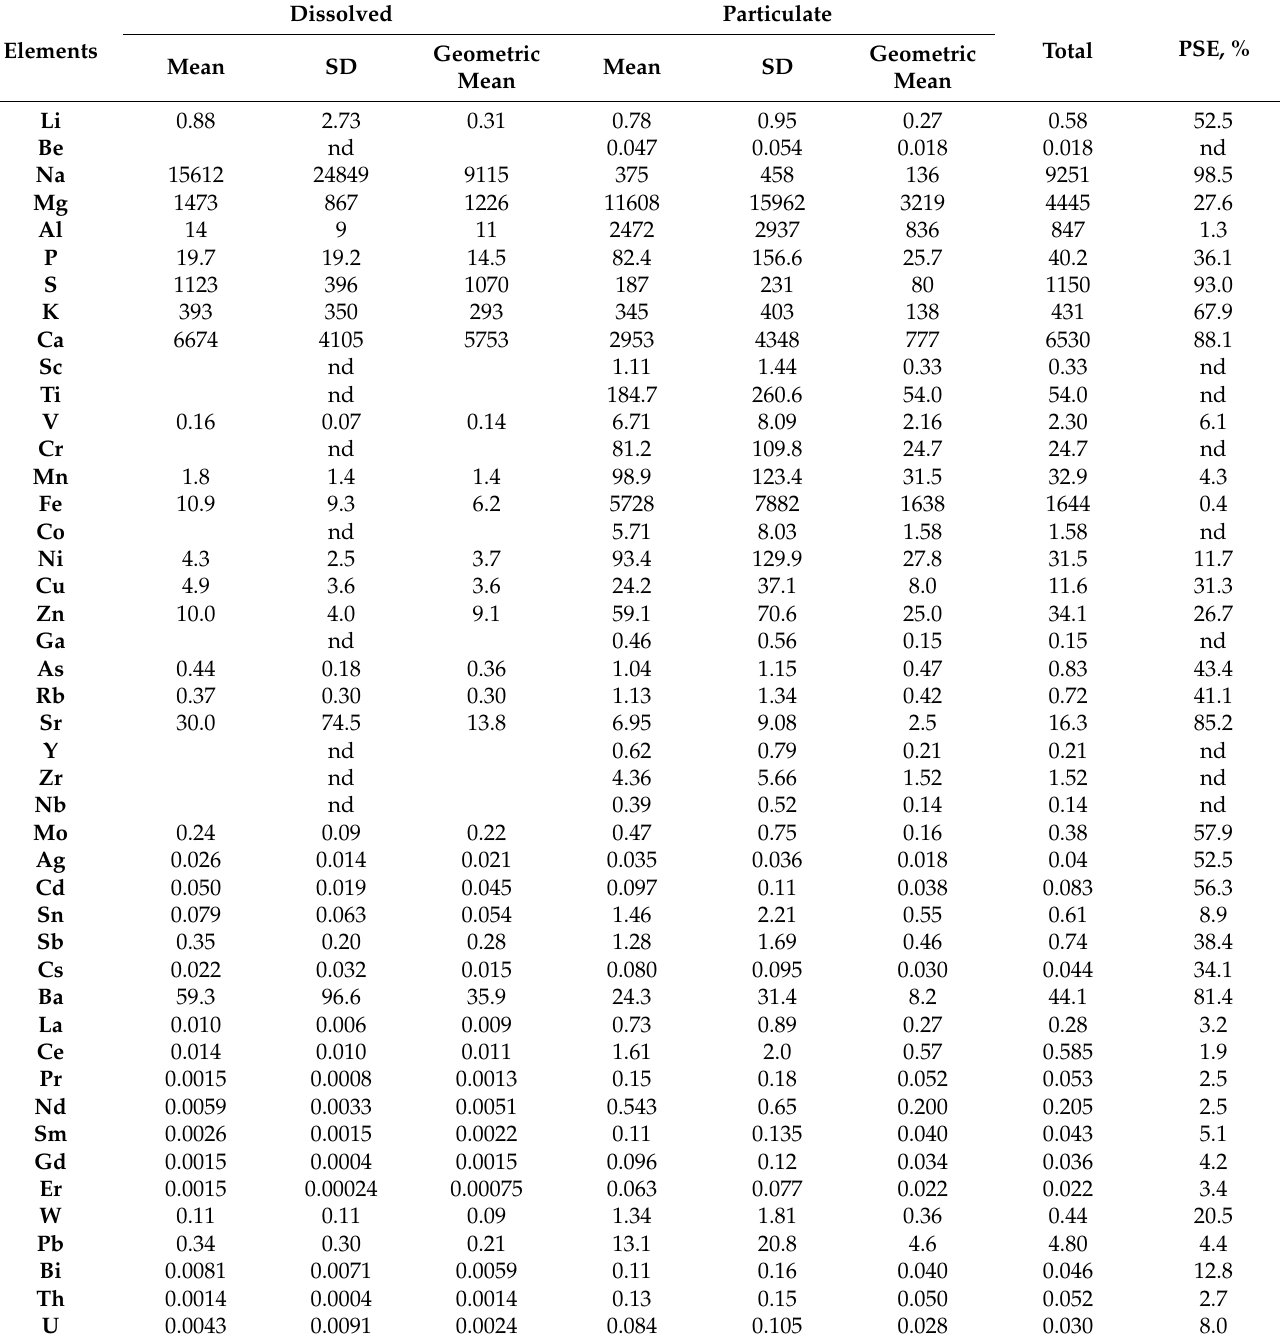
Table 2. The elemental composition ( µ g L − 1 ) of meltwater within the city of